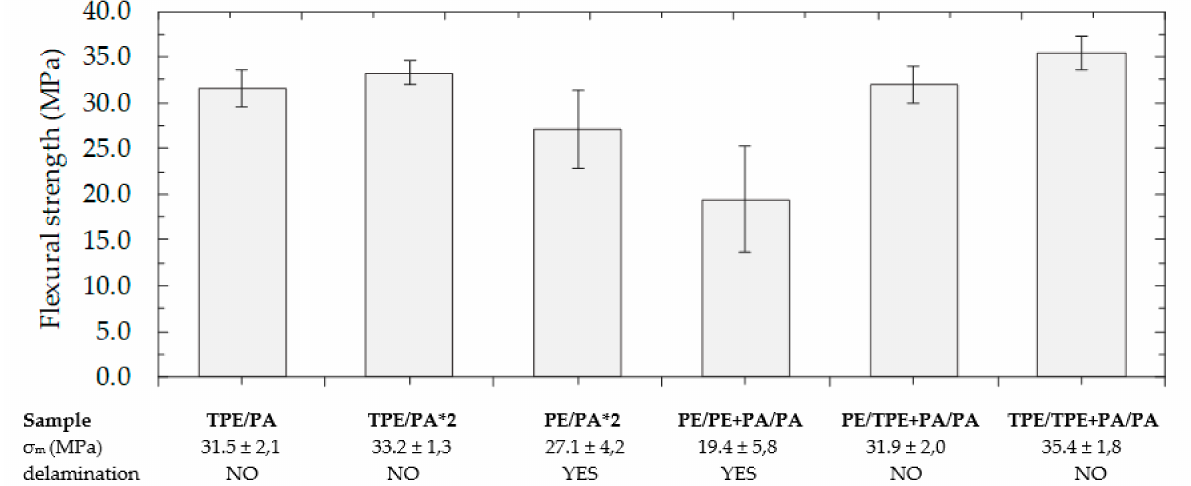
Figure 4. Results obtained from the bending test.